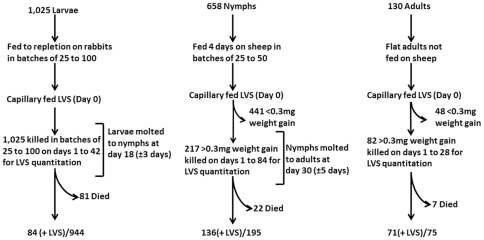
Quantum and duration of colonization and transstadial transmission of LVS experimental design.Larvae, nymphs and adults D. variabilis in batches of various sizes were capillary fed tick meal containing LVS. Ingestion of capillary fed tick meal was determined for nymph and adult ticks by post-feeding weight gains of ≥0.3 mg. Nymphs and adults showing <0.3 mg weight gains were excluded from further analysis. The overall rate of ticks positive for LVS for each tick life cycle stage capillary tube fed LVS is given as total number of ticks which were positive for LVS (+LVS)/total number of ticks tested.